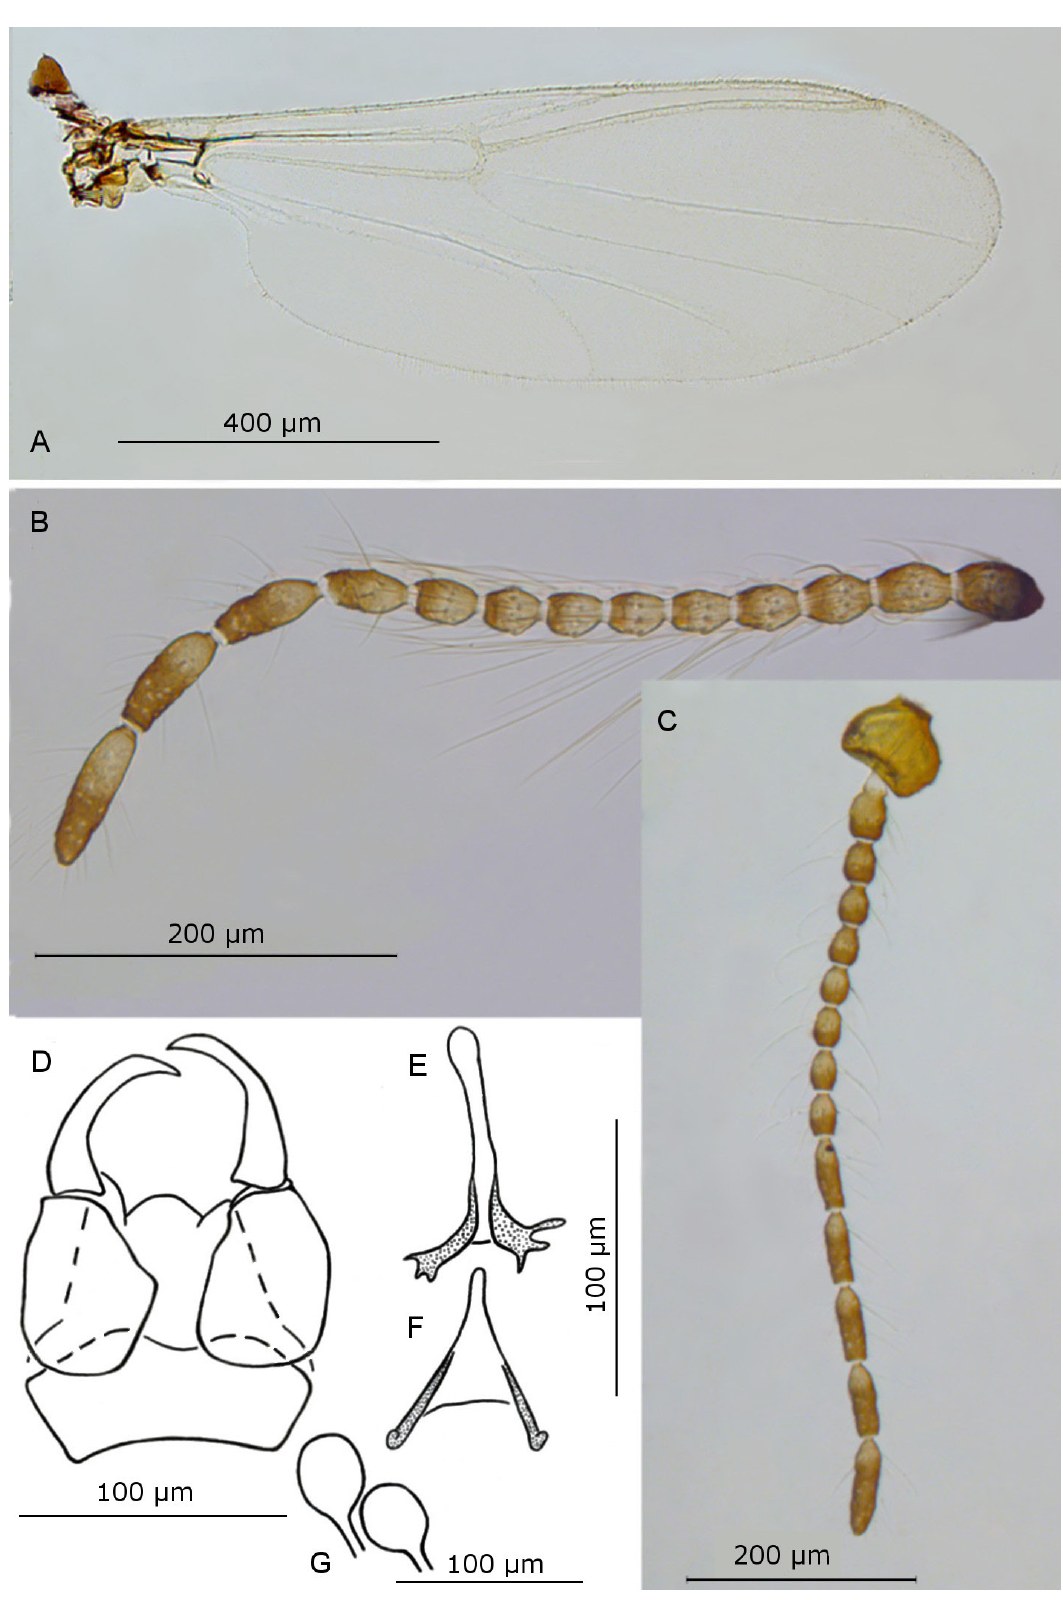
Fig. 2. Bezzia sharjahi Szadziewski & Alwin sp. nov. A . Wing, ♀. B . Antennal flagellum, ♂. C . Antennal flagellum, ♀. D . Genitalia, ♂. E . Parameres. F . Aedeagus. G . Seminal capsules,